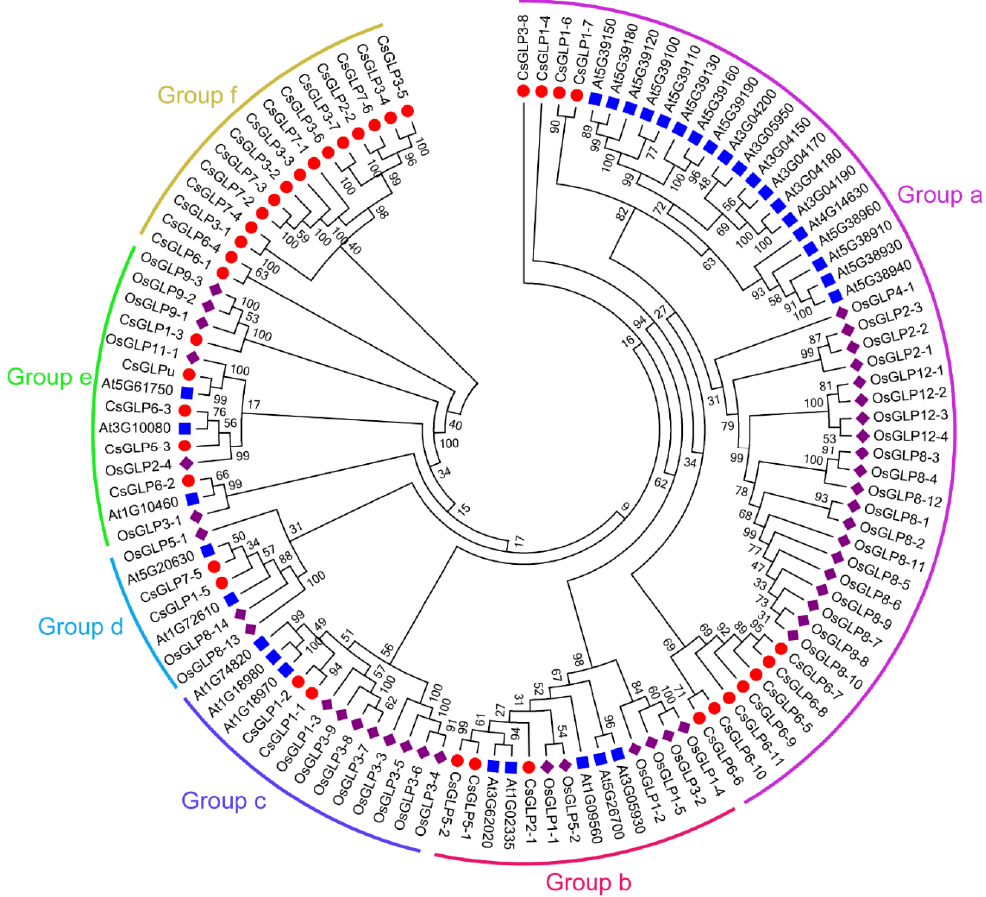
Figure 1. Phylogenetic relationships and subfamily designations of GLP proteins from cucumber, rice and Arabidopsis . The analysis involved 113 amino acid sequences—cucumber (38), rice (43) and Arabidopsis (32)—and their IDs are listed in Table S2. The phylogenetic tree of GLP proteins from cucumber, rice and Arabidopsis was constructed using the NJ method with 1000 bootstrap replicates, and GLP proteins in the tree were divided into six groups (Groups a–f).